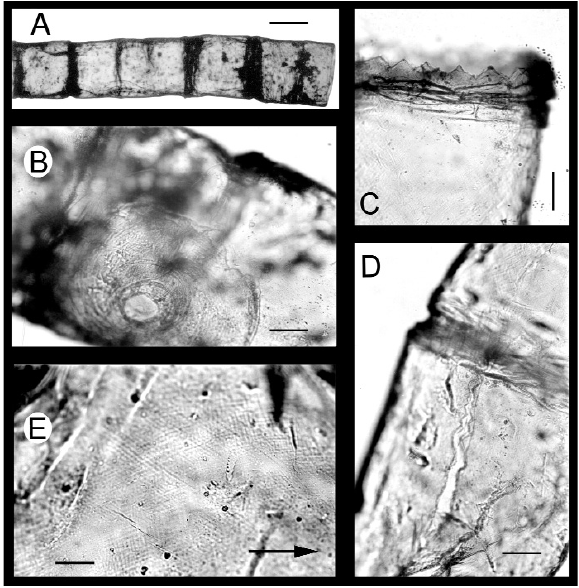
F IG . 2. – Spiochaetopterus creoceanae sp. nov. Tube. A , Part of the tube with marked joints, observed at low magnification; B , A one- hole septum removed by the worm and then attached to the tube wall; C , Serrated opening at border between two successive tube sections; D , Lengthwise tear; E , Traces of the two directions of mucus-layer deposition, observed at high magnification: arrow indi- cates top direction. Scale bars: A = 400 µm; B = 100 µm; C, D = 115 µm; E = 80